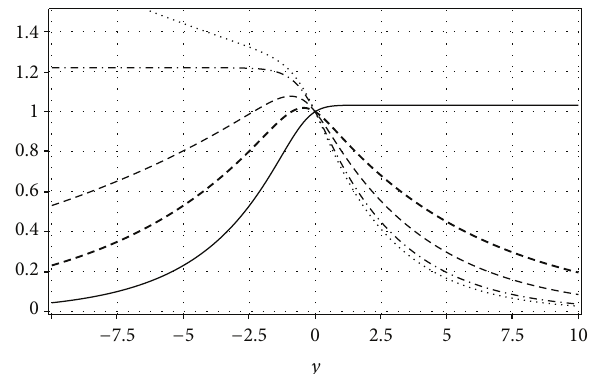
Figure 5: The warp factor 𝑒 2𝐴 with 𝐴 given by (19) for 𝑐 = −1/2 (solid line), 𝑐 = −1/4 (long dashed line), 𝑐 = −1/8 (dashed line), 𝑐 = 0 (dot-dashed line), and 𝑐 = 1/20 (dotted